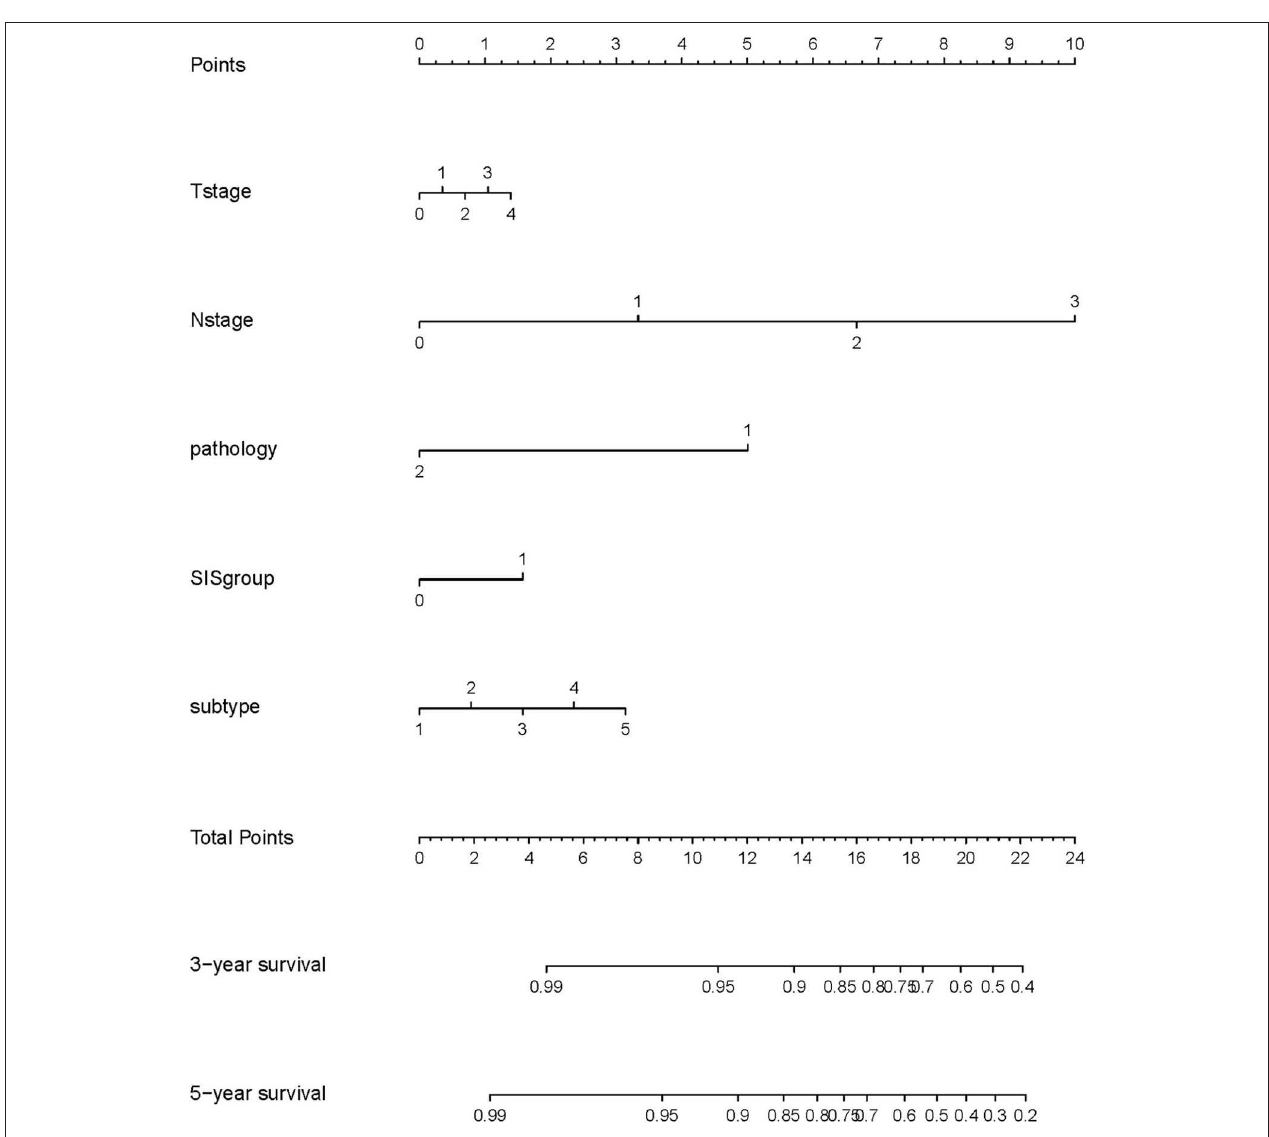
FIGURE 2 | A nomogram predicting the 3- and 5-year overall survival of postoperative breast cancer patients. T stage: 0: T0; 1: T1; 2: T2; 3: T3; 4: T4. N stage: 0: N0; 1: N1; 2: N2; 3: N3. Pathology: 1: invasive ductal carcinoma; 2: others. SIS group: 0: low SIS group; 1: high SIS group. Subtype: 1: Luminal A; 2: Luminal B/HER2-; 3: Luminal B/HER2 + ; 4: HER2 Enriched; 5: Triple